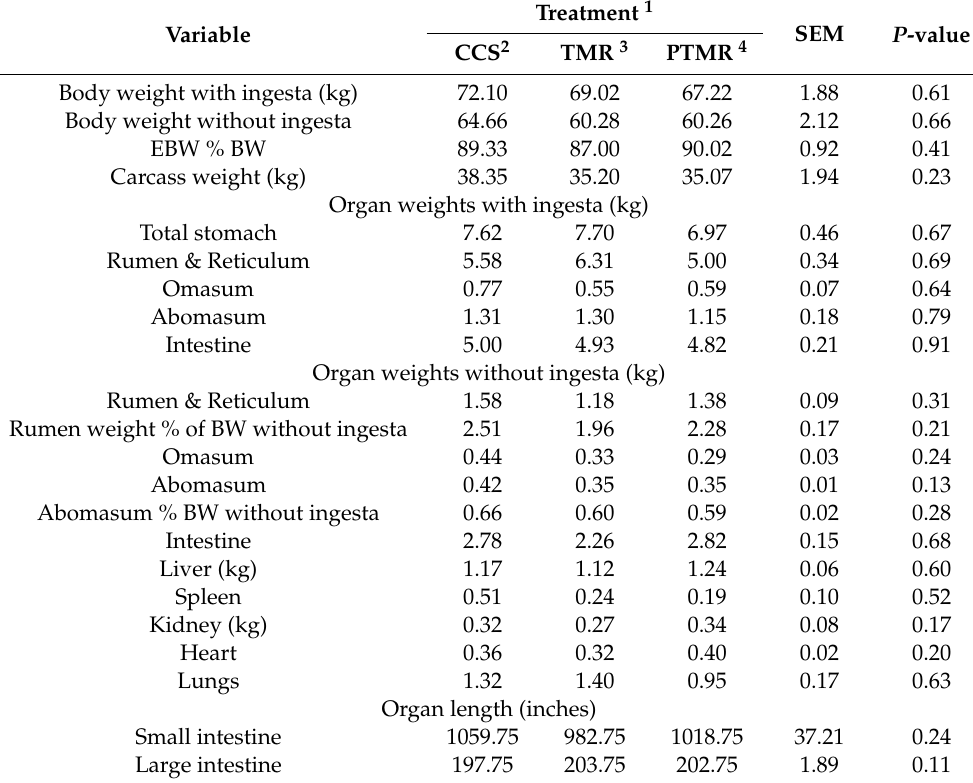
Table 7. Means of Organ weights with or without ingesta of sacrificed crossbred male calves fed CCS, TMR, and